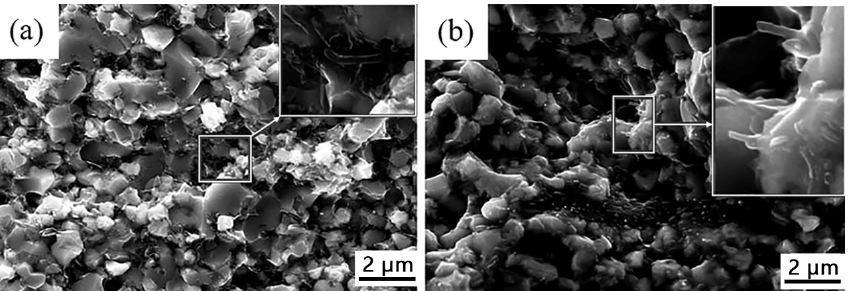
Fig. 8 Fracture morphologies of ZrB 2 –CNT ceramics sintered at 1600 ℃ (a) and 1650 ℃ (b). Reproduced with permission from Ref. [154], © Maney Publishing 2016.